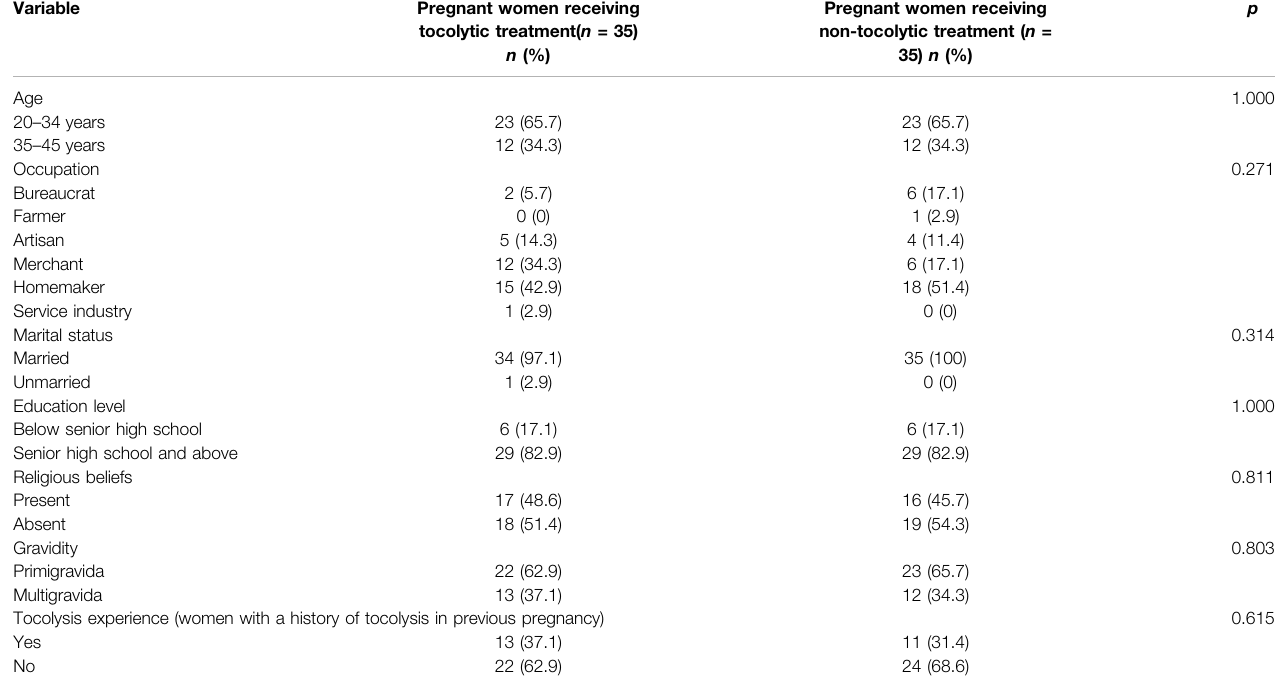
TABLE 1 | Analysis of demographic variables ( n = 70).